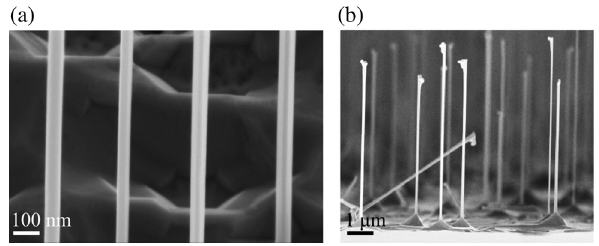
FIG. 6. Scanning electron microscopy images of InAs nano- wires. (a) The faint shadows along the nanowire axis are atomically flat facets. (b) Nanowires on their (111)B InAs substrate. The tilted nanowire randomly grows in the (100)